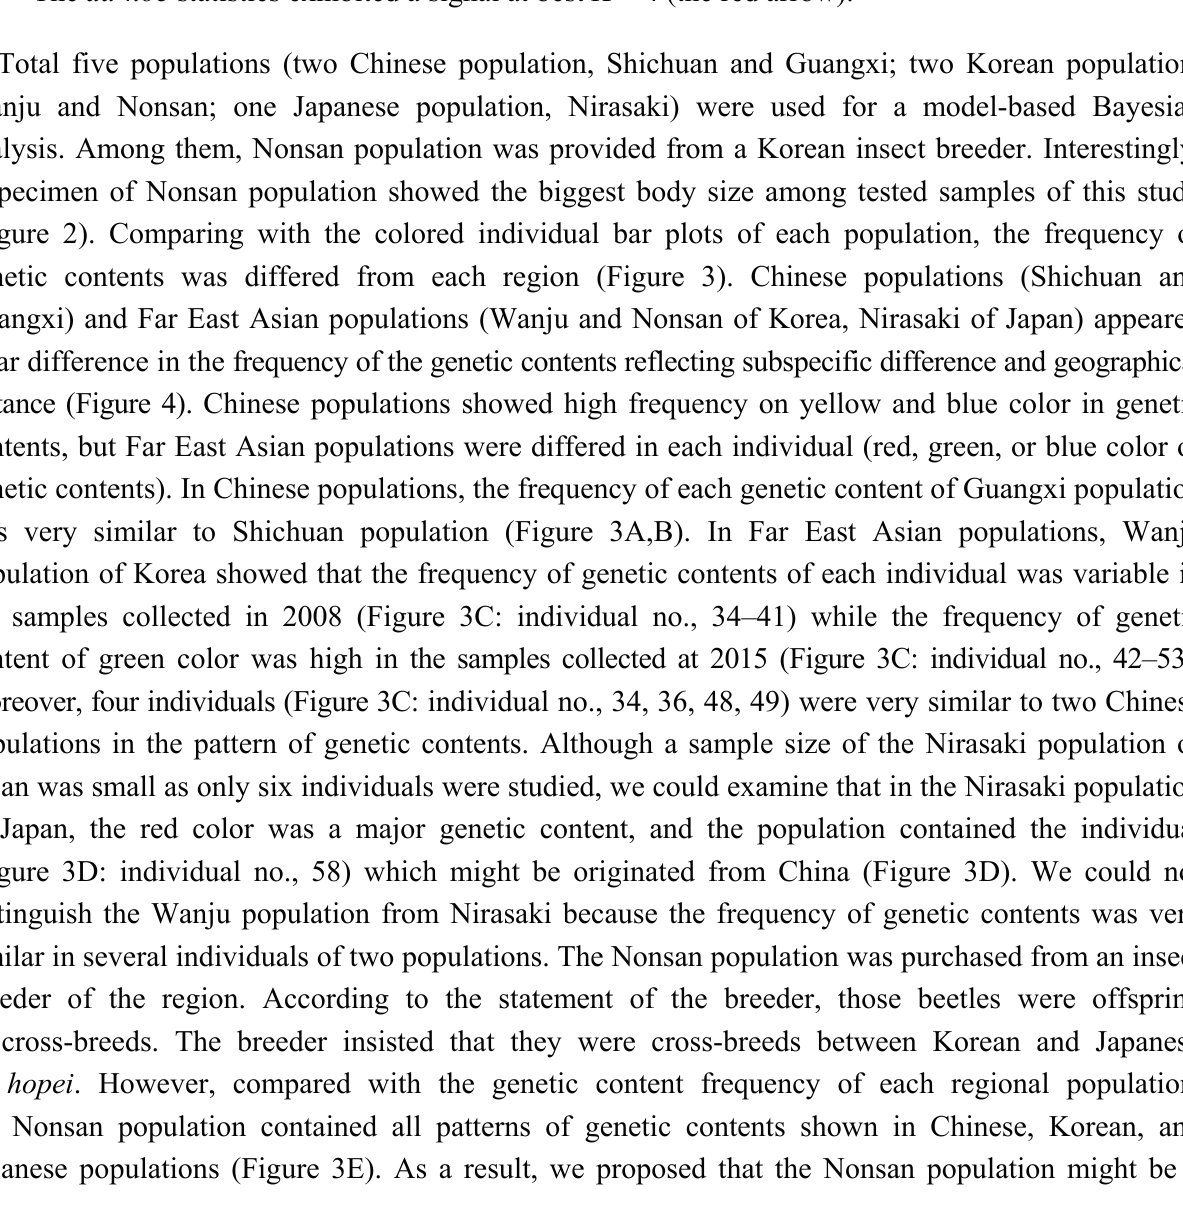
Figure 1. The ad-hoc statistics ∆ ( K ) on the basis of LnP(D) estimated 20 iterations for each K . The ad-hoc statistics exhibited a signal at best K = 4 (the red